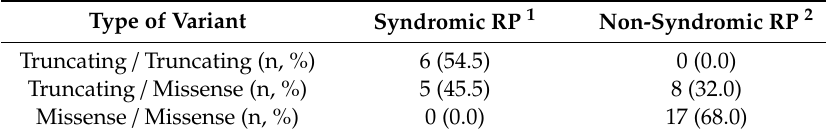
Table 3. Three types of combinations of USH2A variants in this